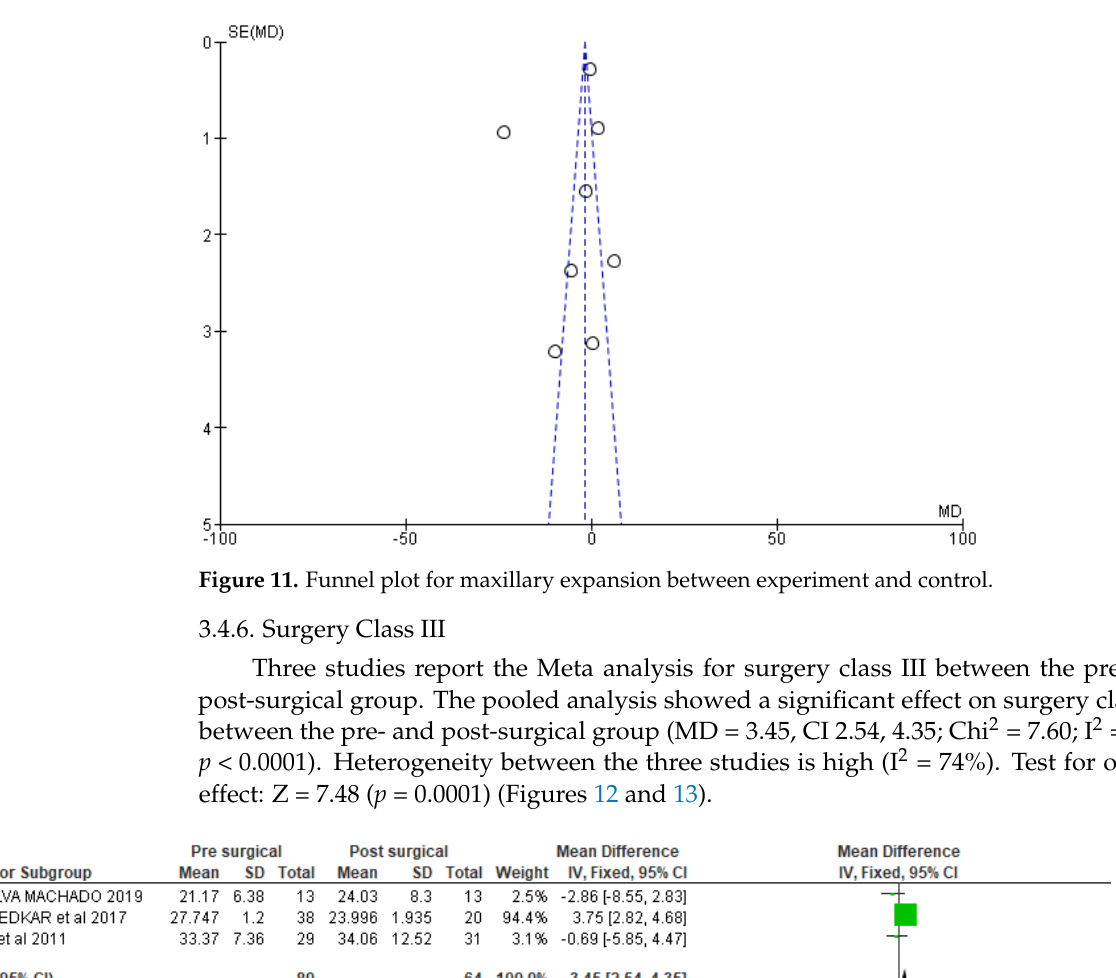
Figure 10. Forest plot for maxillary expansion between experiment and control.